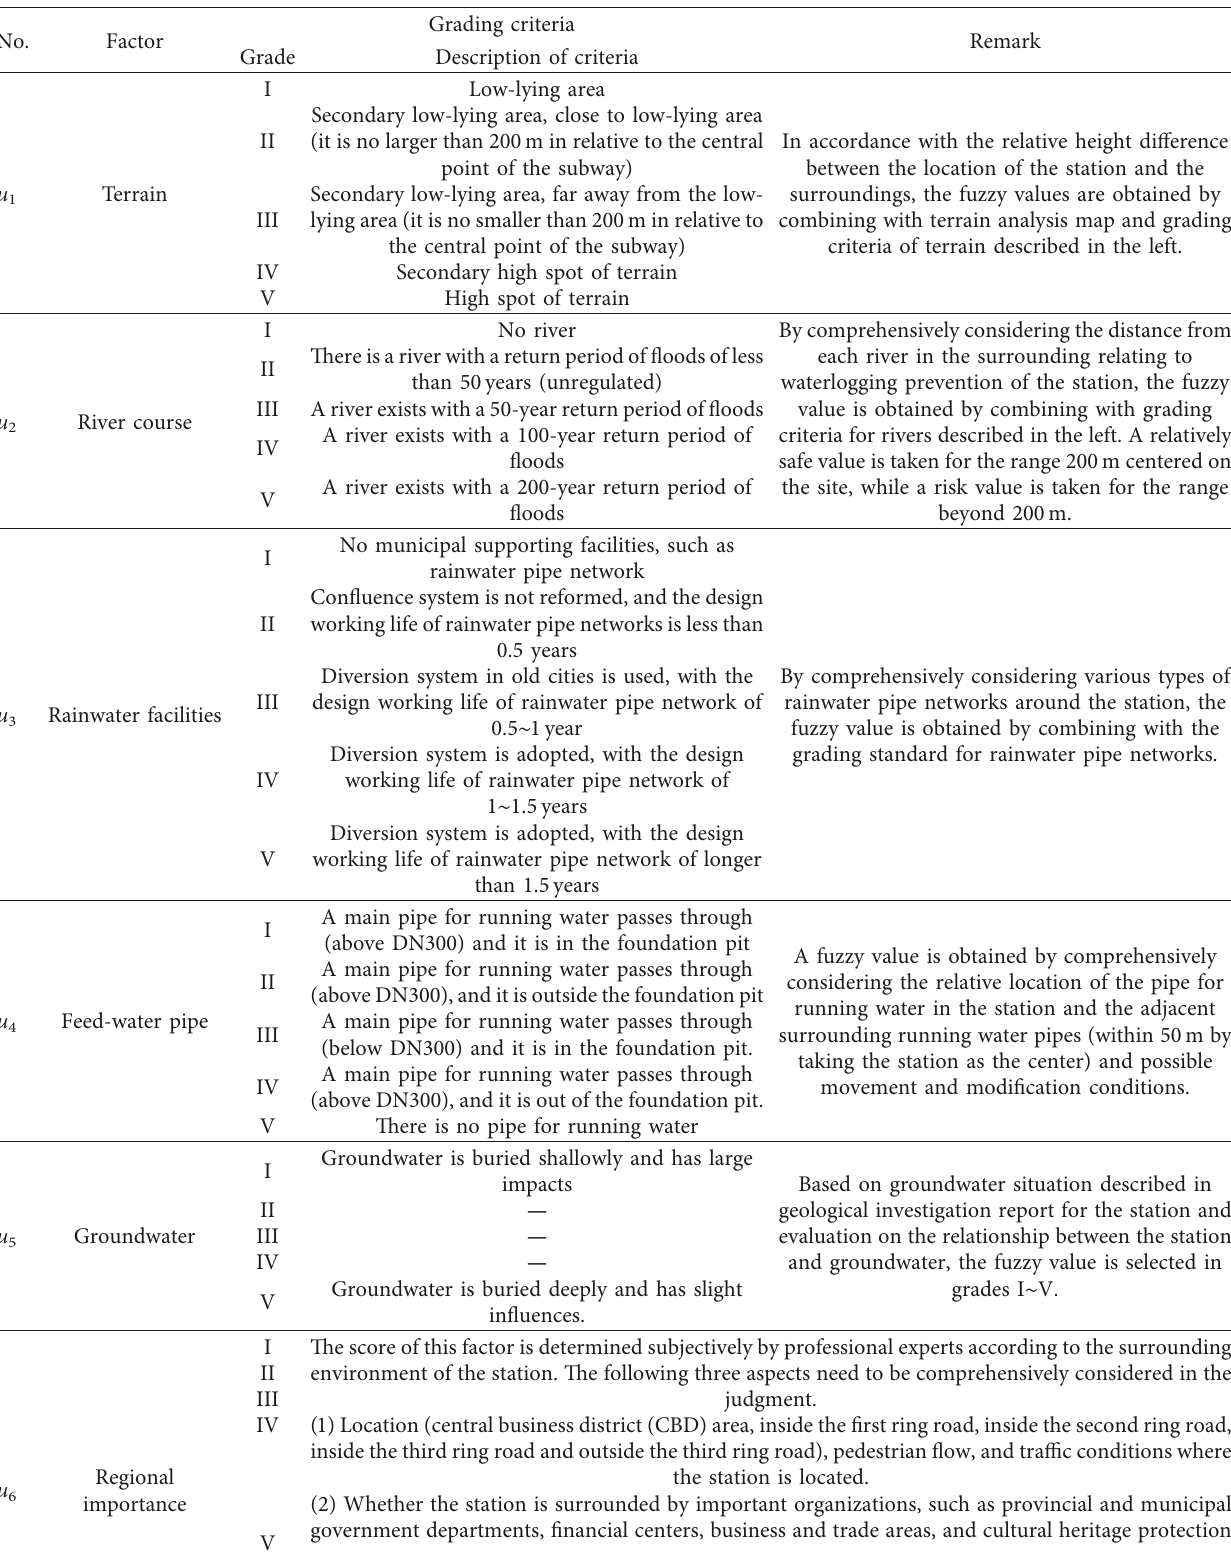
Table 4: Description of judgment criteria for each